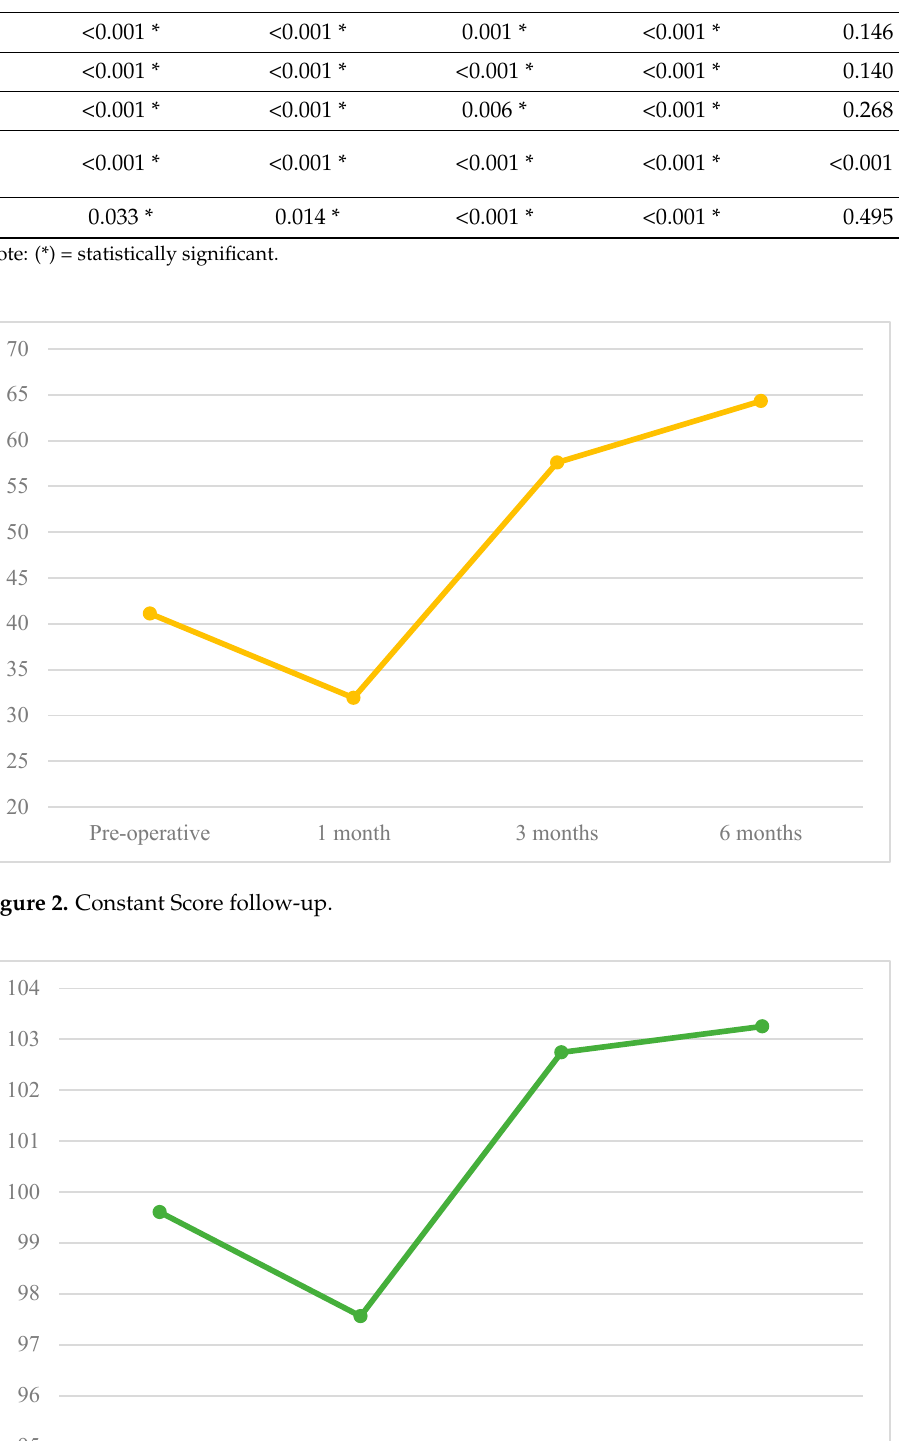
Figure 3. SF-36 follow-up.